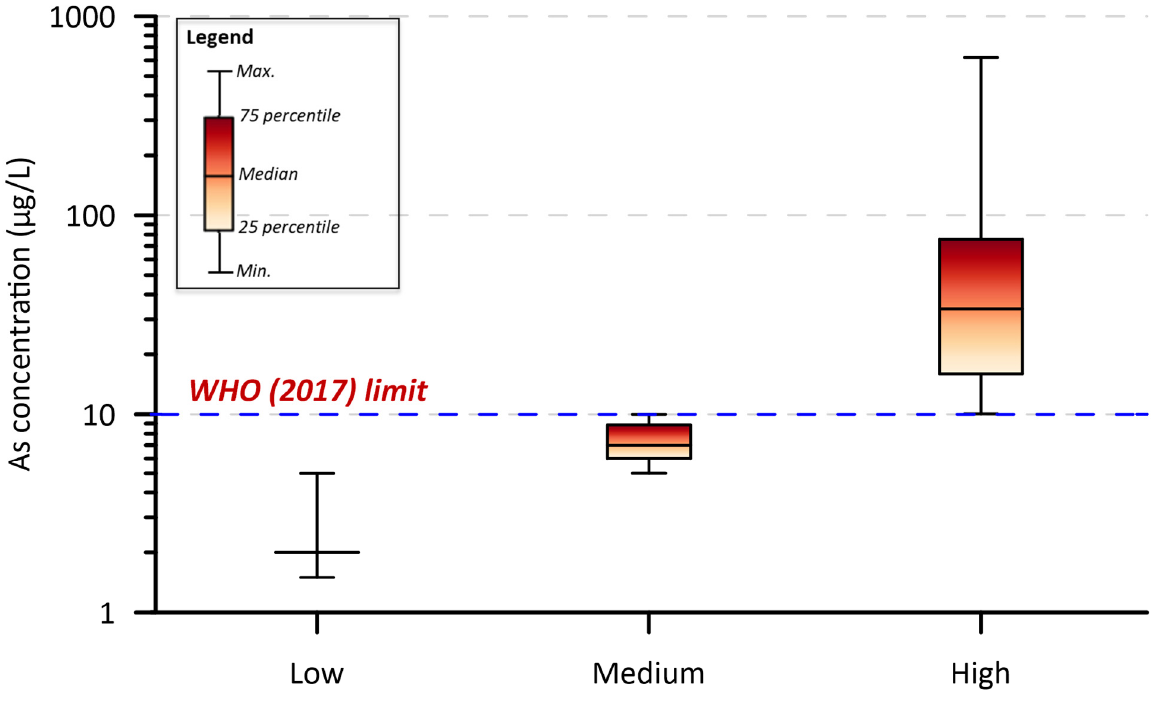
Figure 3. Arsenic concentrations in surface water and groundwater illustrated using box and whisker plot.